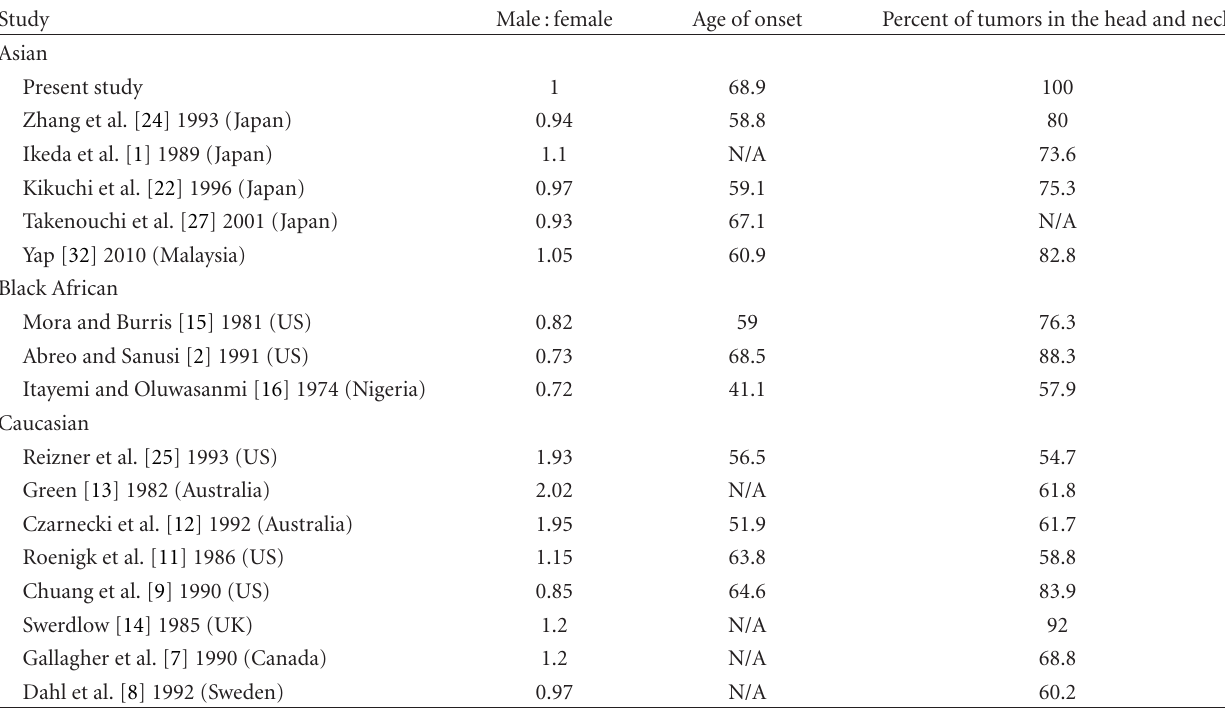
Table 3: Impact of race on gender distribution of patients with cutaneous basal cell